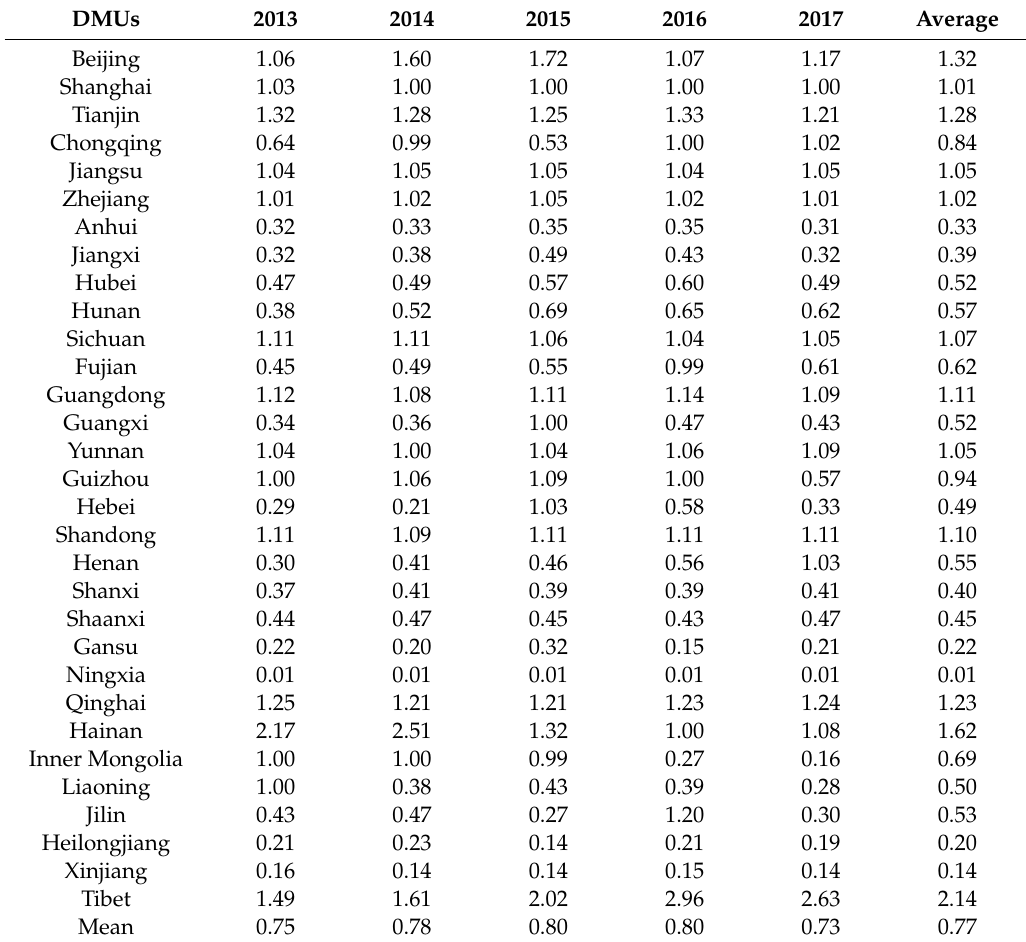
Table 6. Water resources’ use e ffi ciency during